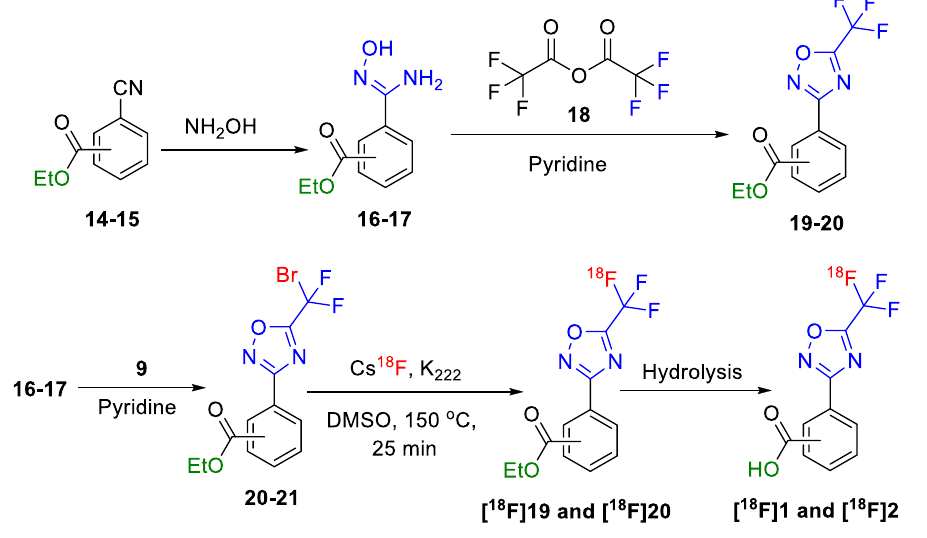
Figure 3. Radiosynthesis of 18 F-TFMO containing esters and benzoic